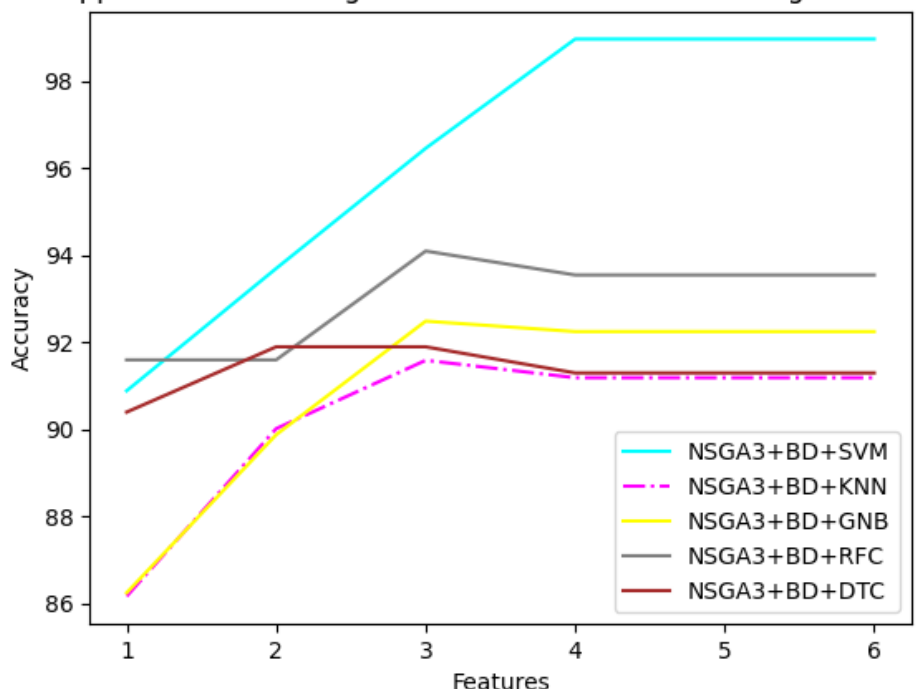
Figure 7. Wrapper-based NSGA3 + Bi-directional elimination for the classifiers.